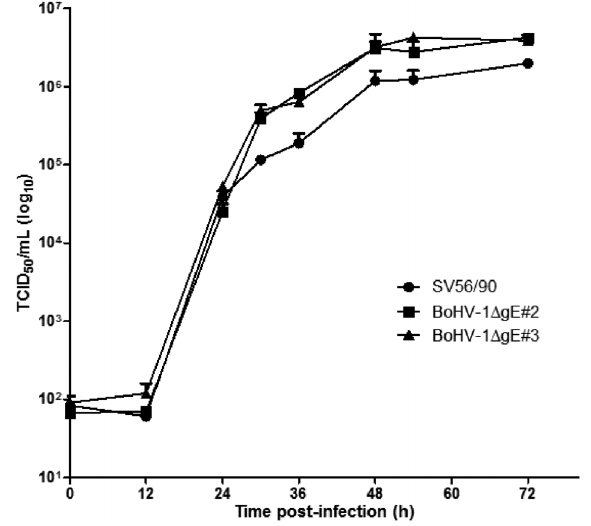
Figure 5. Virus growth curve. MDBK cells were inoculated with the parental virus (BoHV-1 SV56/90) or the recombinant viruses (BoHV- 1 Δ gE clones #2 and #3). At different times post-infection, cells were freeze-thawed and the viral progeny were quanti fi ed. The virus titers are reported as log 10 TCID 50 /mL. Data are reported as means ± SE of three different titrations for each time point.